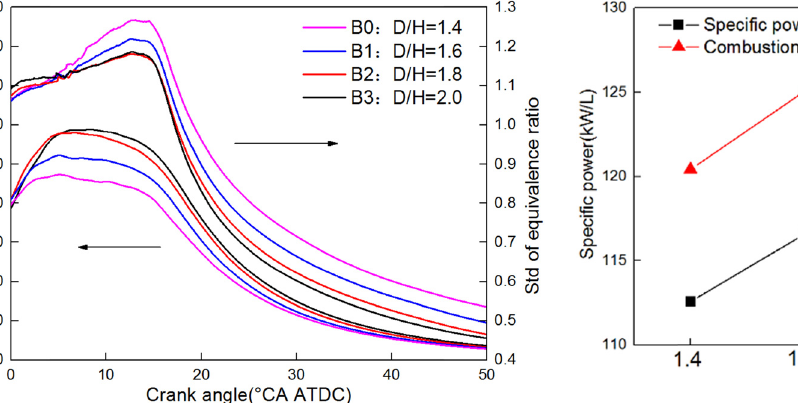
Figure 17: Speci fi c power and combustion e ffi ciency under di ff erent diameter - to - depth ratios.